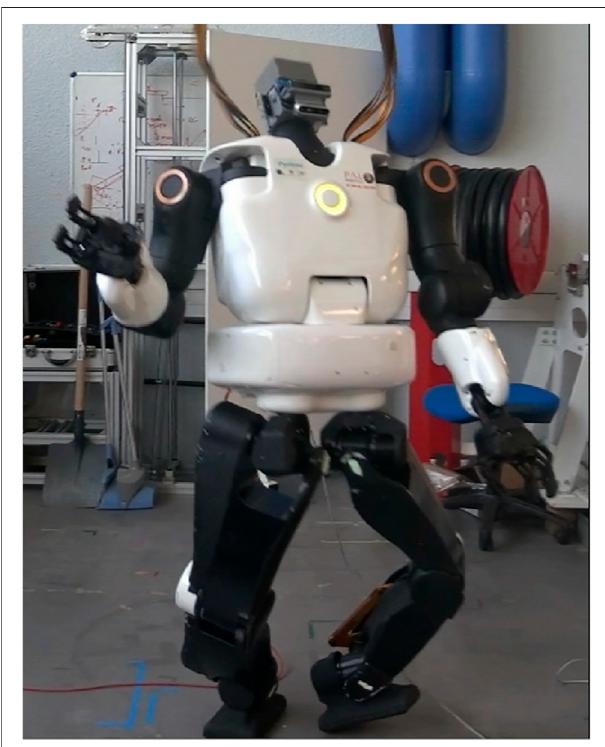
FIGURE 12 | Failed experiment using torque control for a postural task.